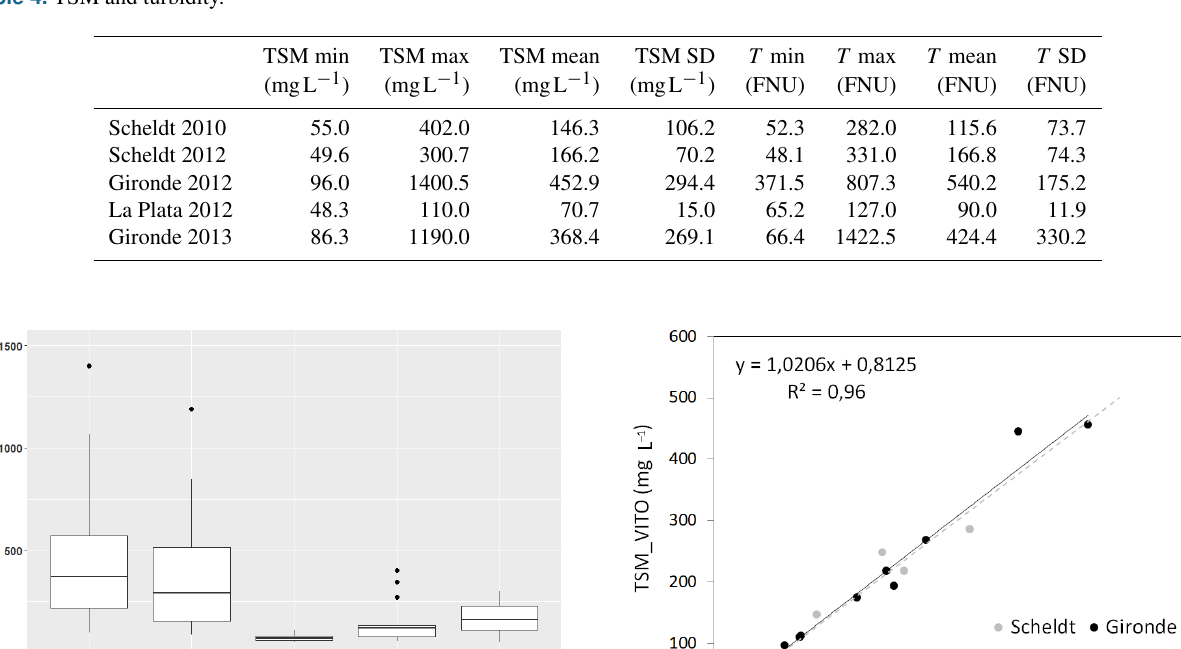
Figure 7. ASD water reflectance versus TRIOS water reflectance (a) for wavelengths at 412, 490 and 555nm and (b) for wavelengths at 683, 780 and 865nm. Table 4. TSM and turbidity.